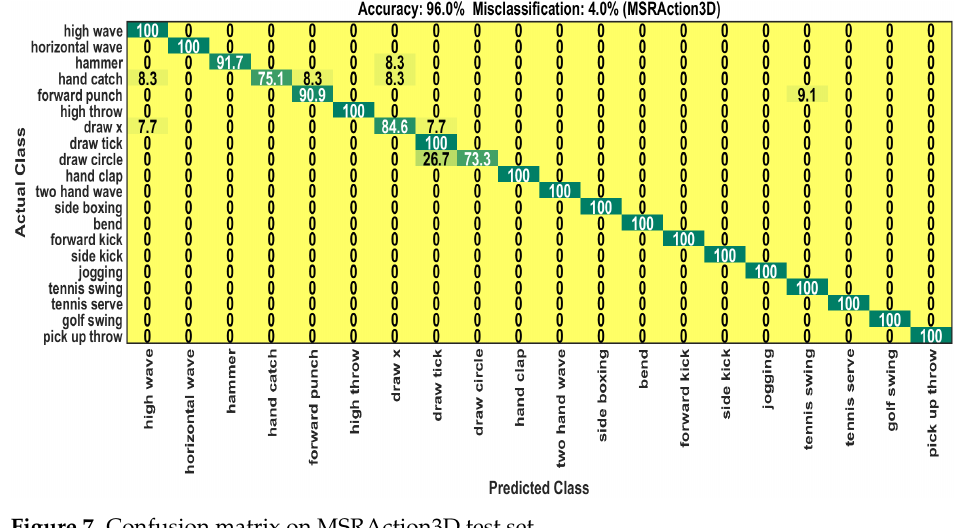
Figure 7. Confusion matrix on MSRAction3D test set. Table 3. Comparison of our highest action recognition accuracy (%) with state-of-the-art frameworks on the DHA test